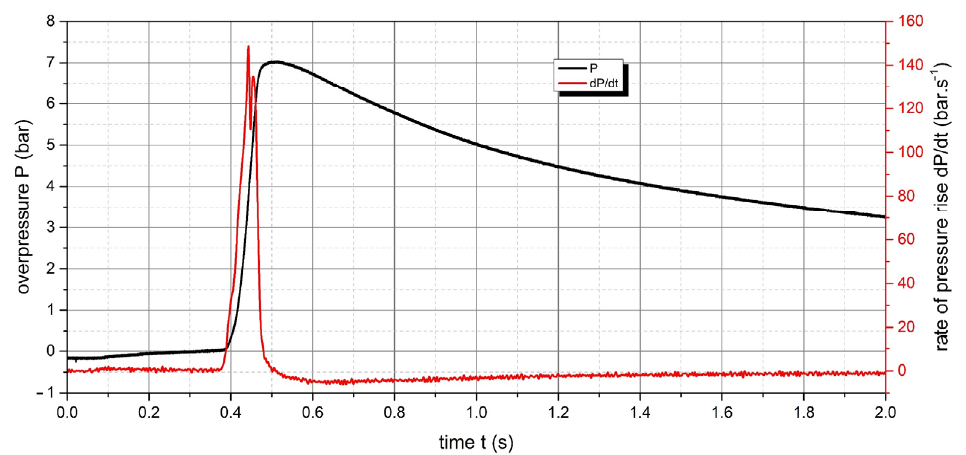
Figure 7. Overpressure P and rate of pressure rise dP/dt of 250 g·m − 3 Lycopodium clavatum powder ignited by Igniter 2 (shelf life more than 2 years).